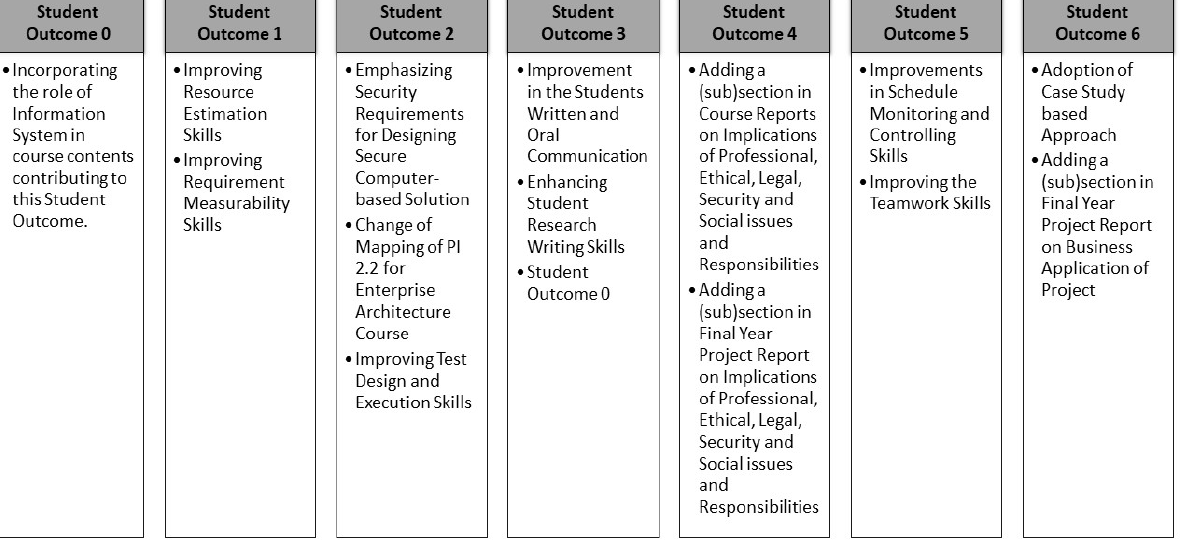
Figure 3. Continuous Improvement Action Plan